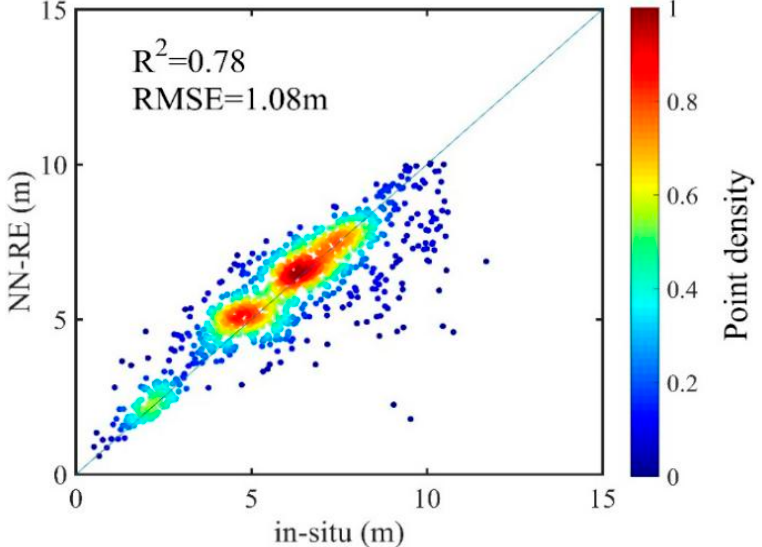
Figure 4. Correlation between the in situ depths and the water depth estimation results based on multiple training sets of satellite image data and neural networks (NN).